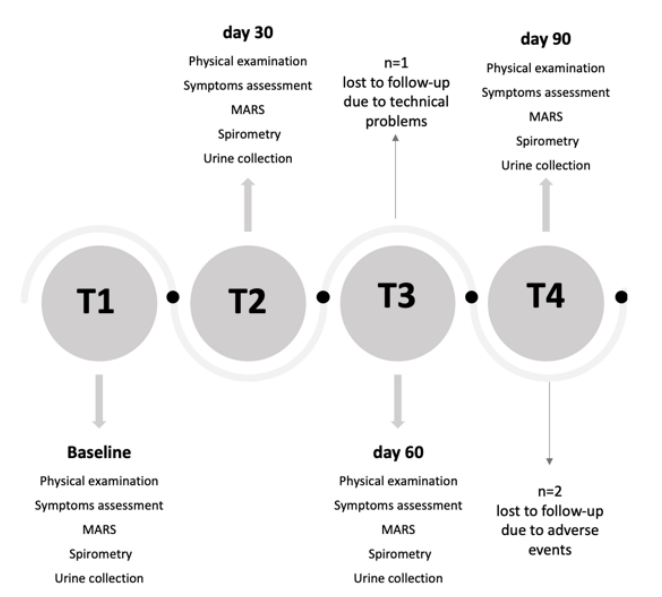
Figure 1. Study flow chart. MARS: Medication Adherence Rating Scale.